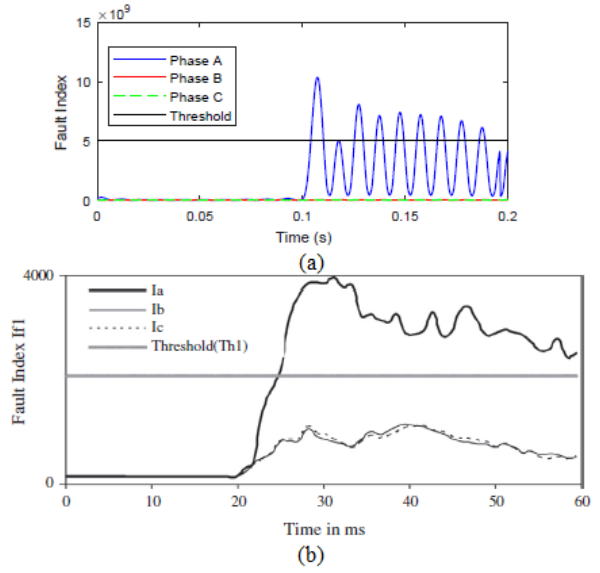
Figure 13. Fault index for the L-G fault ( a ) computed using the proposed algorithm and ( b ) computed using the algorithm reported in